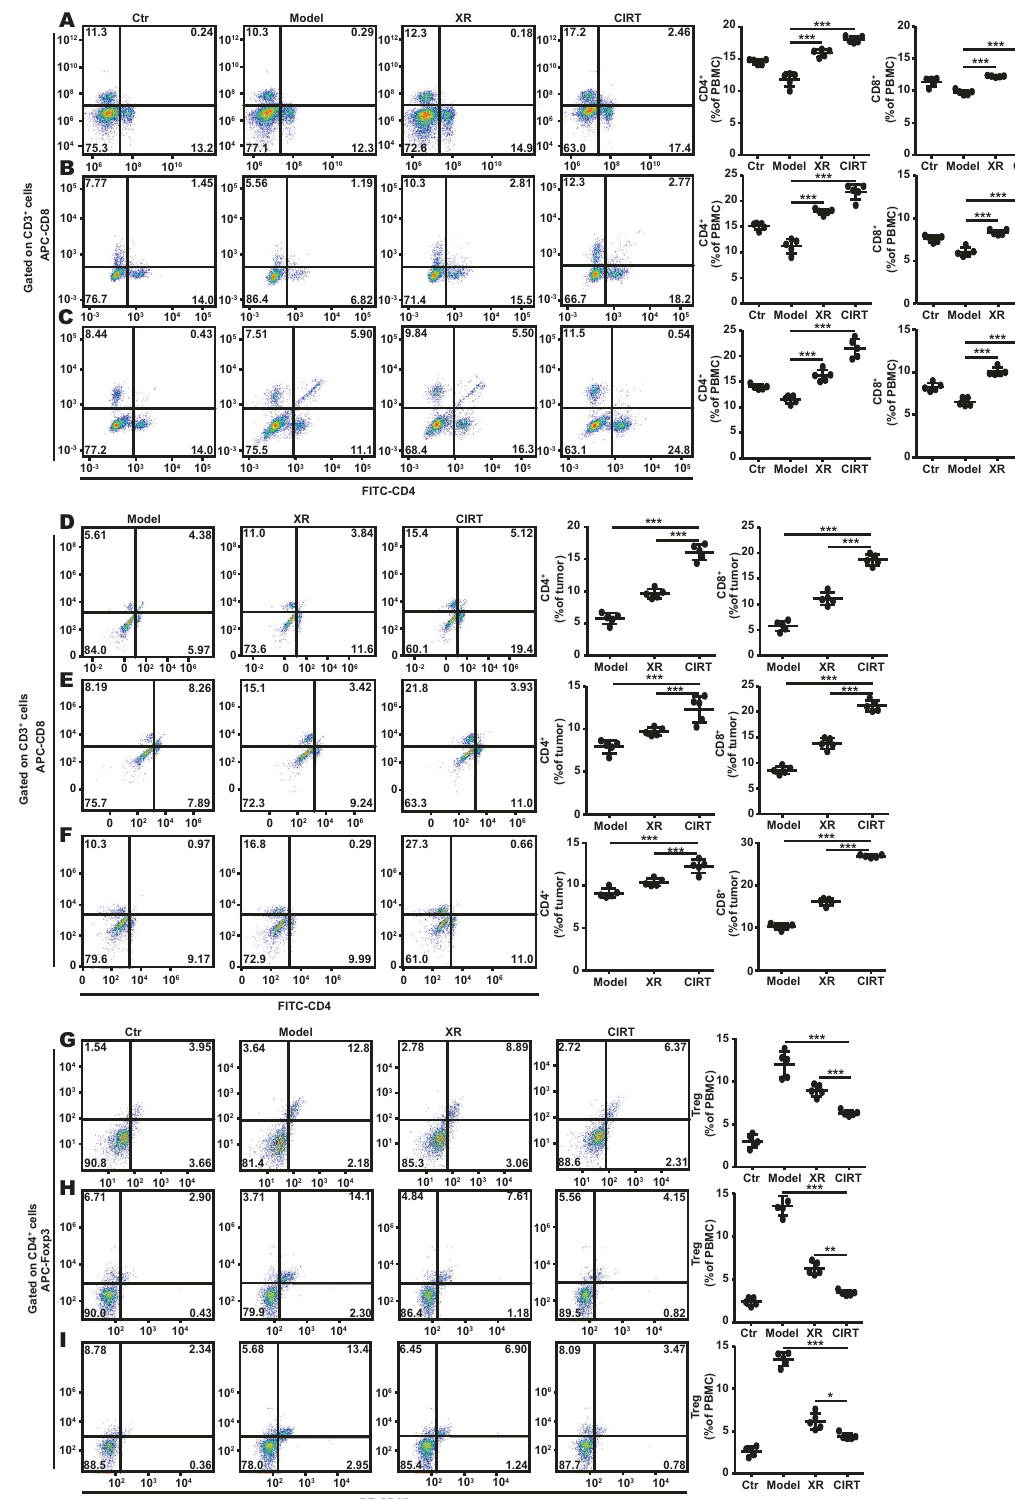
Fig. 3 Carbon ion radiation boosts T cell proliferation in vivo. The C57BL/6 mice (Ctr) bearing subcutaneous B16, MelanA and S91 melanoma (model) were locally irradiated with the physical dose of 5 Gy X-ray (XR) or 5 GyE carbon ions (CIRT) on the tumour sites. On the 7